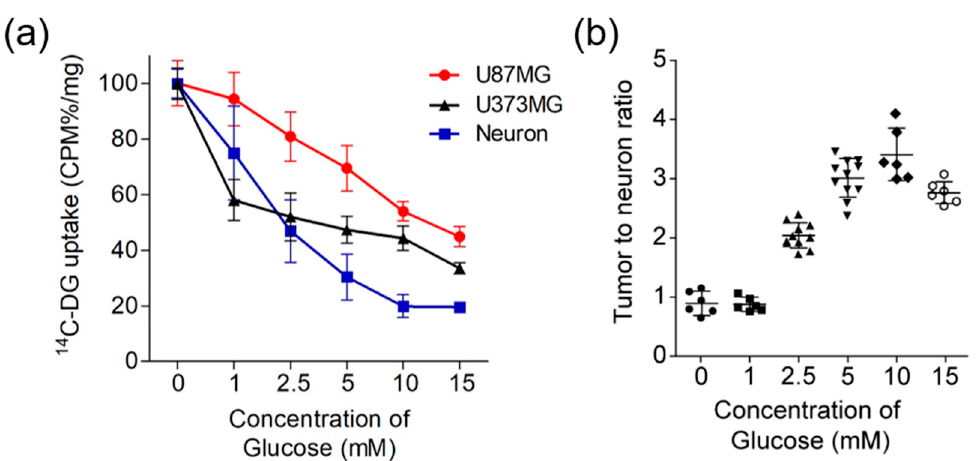
Figure 2. In vitro 14 C-2-Deoxy-D-glucose ( 14 C-DG) uptake in U87MG, U373MG and mouse primary neurons. ( a ) 14 C-DG uptake and ( b ) U87MG tumor-to-neuron ratio for di ff erent glucose concentrations in the media.